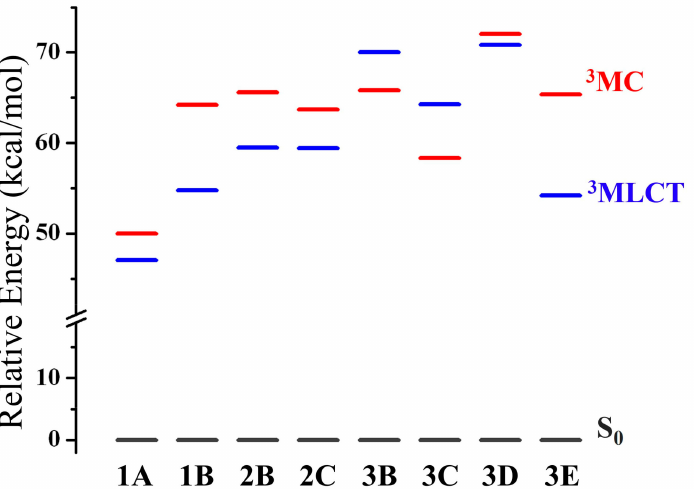
Figure 4. Energy level diagram of all complexes under study of 3 MLCT, 3 MC and S 0 states